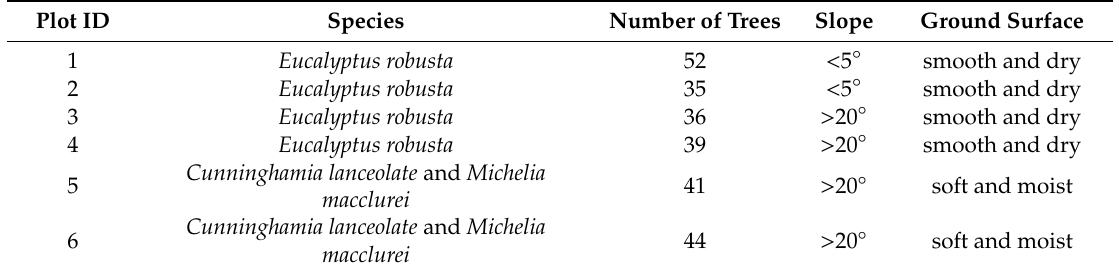
Table 1. Forest conditions of the test plots.